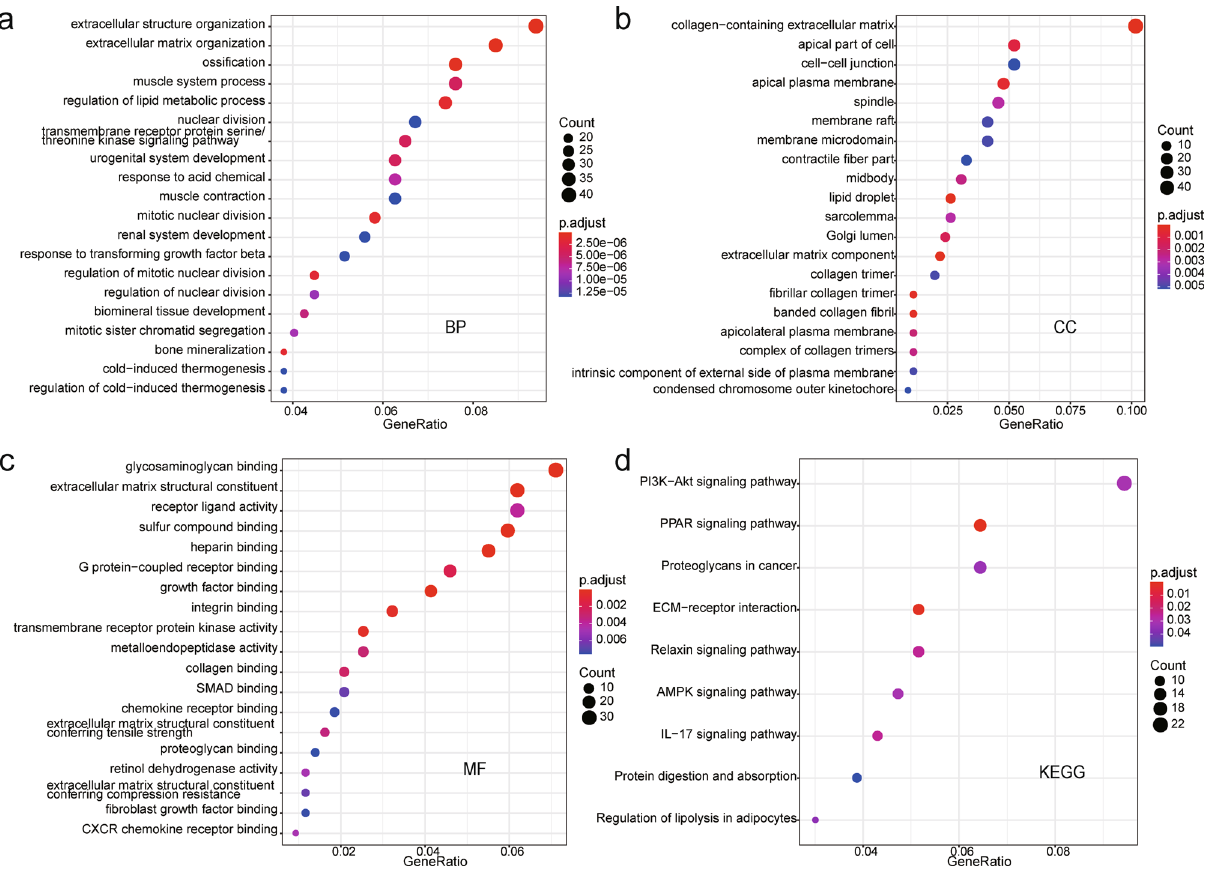
Figure 1. GO enrichment analysis and KEGG pathways analysis of 512 DEGs. ( a) GO terms of biological process (BP); ( b) GO terms of cellular component (CC); ( c) GO terms of molecular function (MF); ( d) KEGG pathways terms.